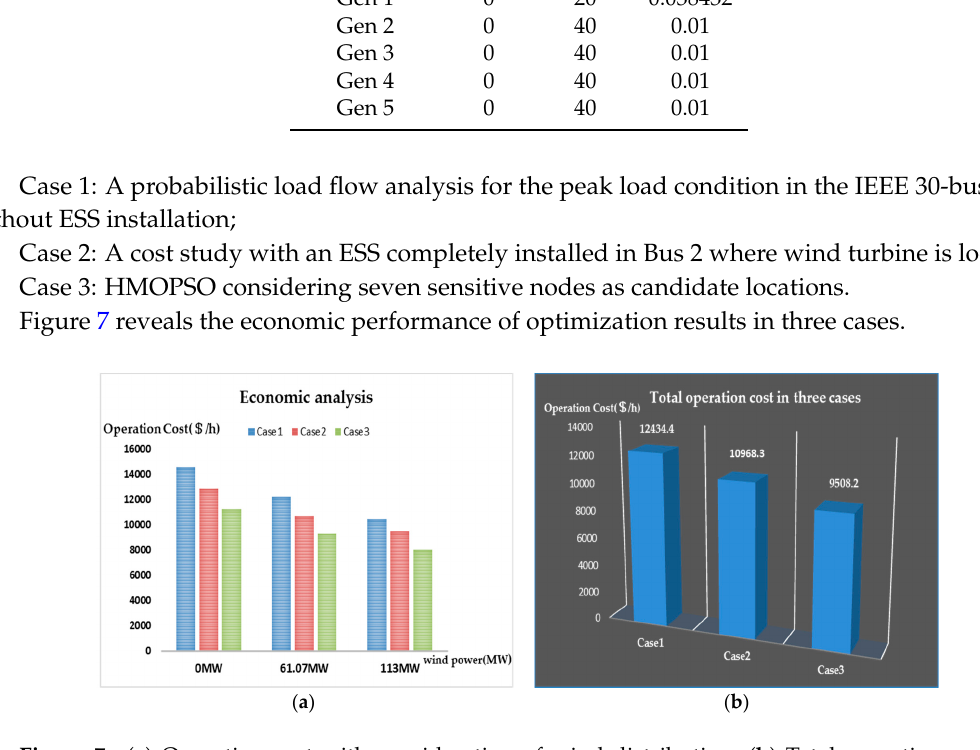
Figure 6. ( a ) Power–voltage ( P ‐ V ) curves for generation areas of the IEEE 30 bus system; ( b ) P ‐ V curve for loading areas of the Institute of Electrical and Electronic Engineers (IEEE) 30 bus system. Table 2. Fuel cost parameters of diesel engines.